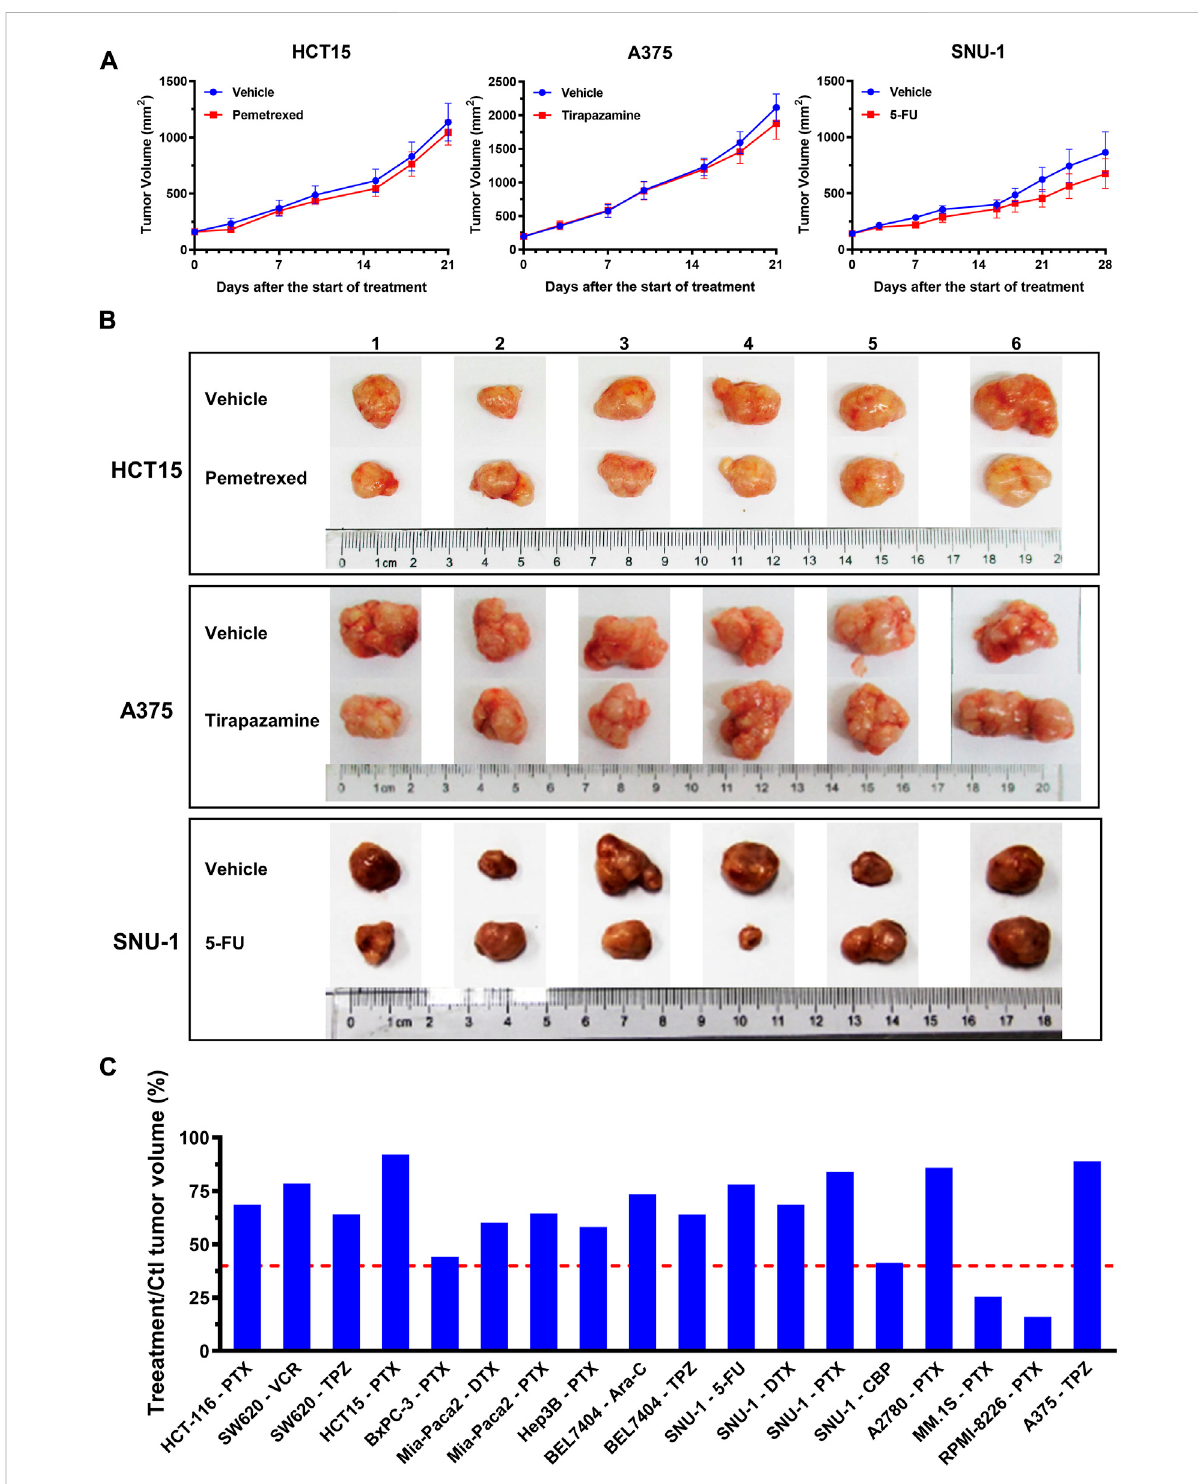
FIGURE 6 Drug ef fi cacy evaluation on the in vivo CDX model. (A) Tumor growth curves on the in vivo CDX model with or without drug treatment. Pemetrexed, tirapazamine and 5-FU were injected into the HCT15, A375 and SNU-1 xenografted models, respectively. Values are presented as means ± S.D. (B) Images of excised tumor tissues with or without drug treatment after sacri fi cing the mice at the end of the experiments. (C) The in vivo T/C values from our experiments. The T/C threshold of 40% was labeled in the red dotted